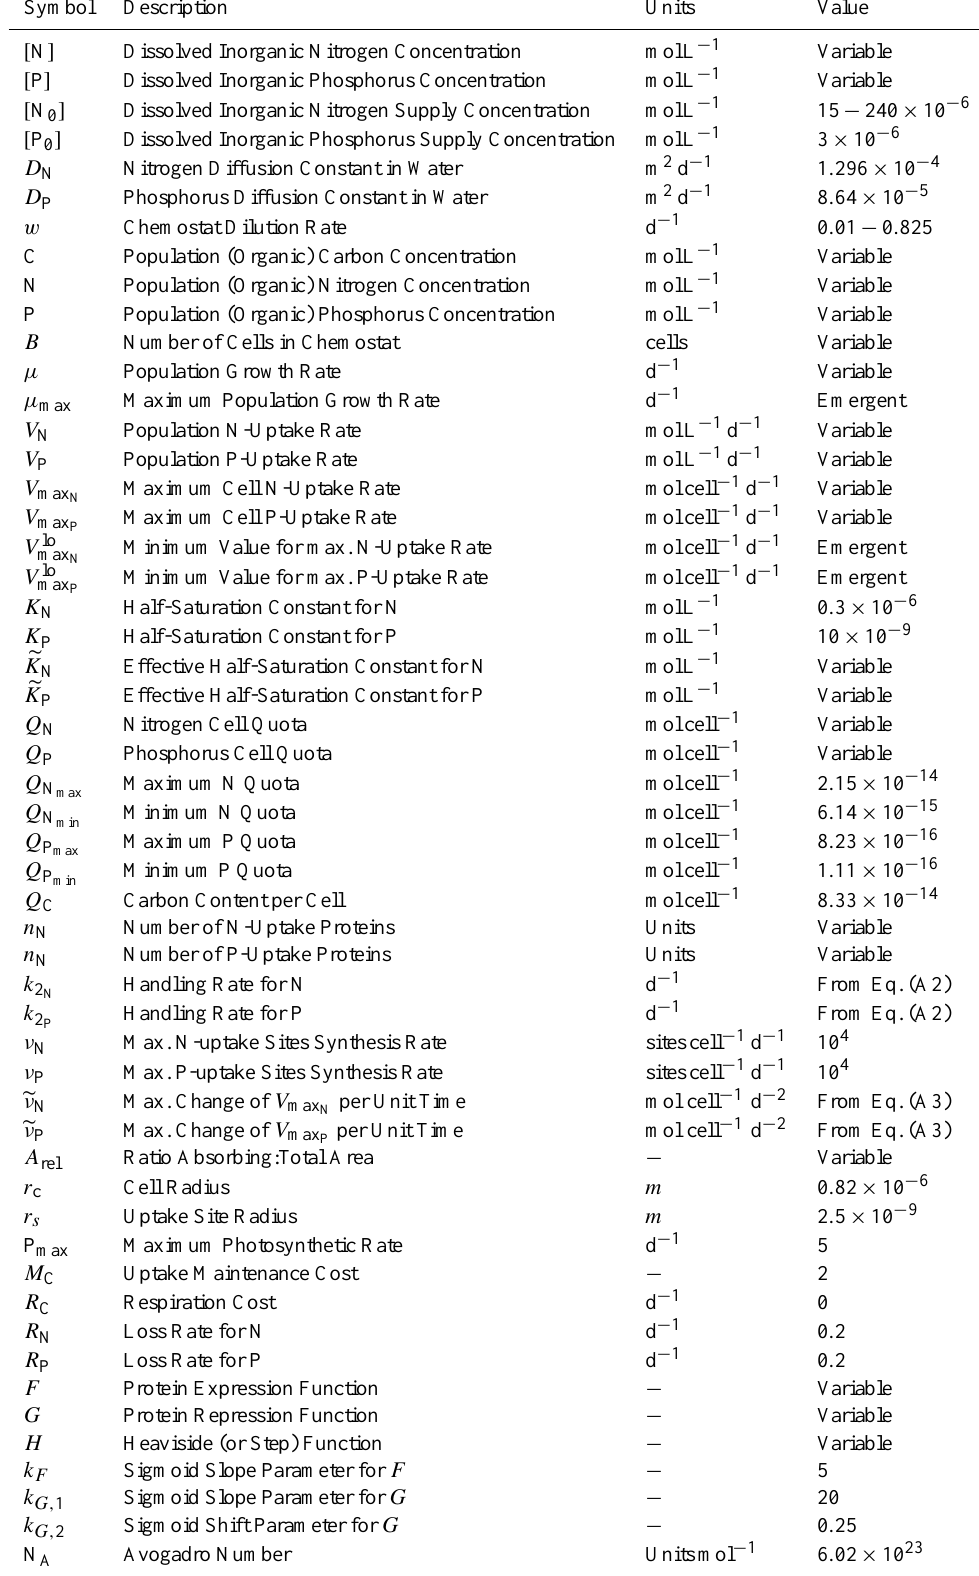
Table A1. List of variables and parameters used in this manuscript, representing a generic Synechococcus strain – values collected from Healey (1985); Ikeya et al. (1997); Hense and Beckmann (2006); Pahlow and Oschlies (2009); Flynn et al. (2010); Bonachela et al.